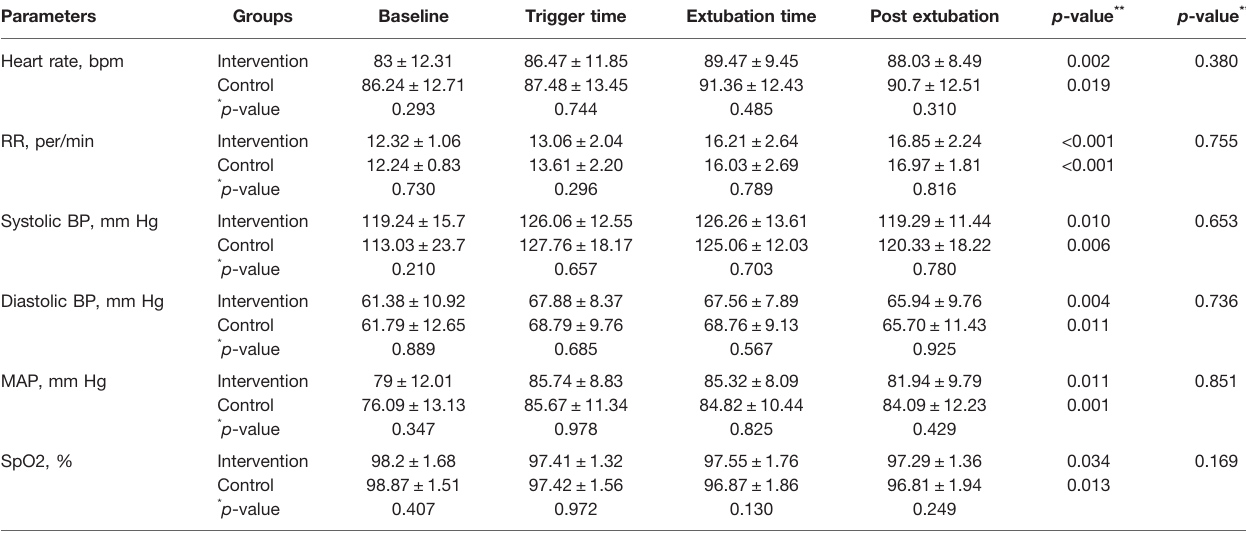
TABLE 3 | Comparison of vital signs of patients on different times between the intervention and control groups. Parameters